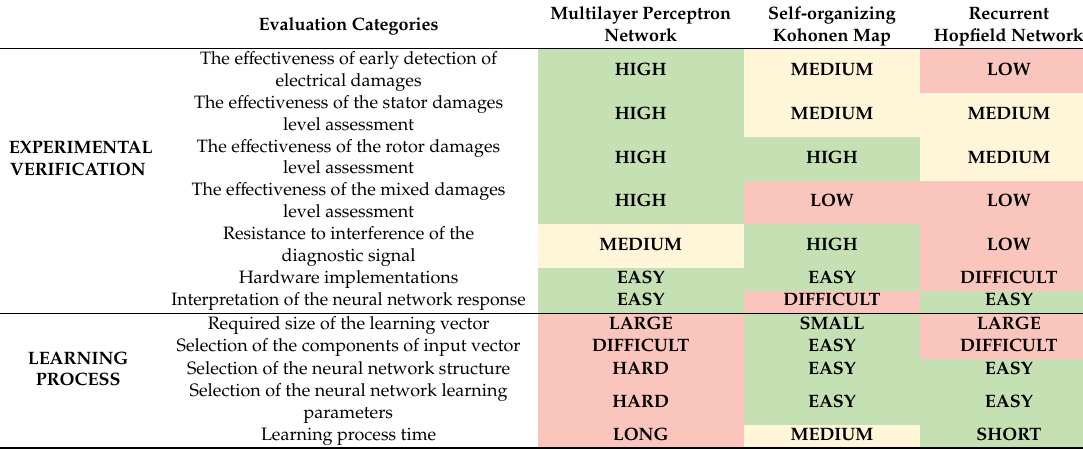
Table 3. Comparison of the used neural network